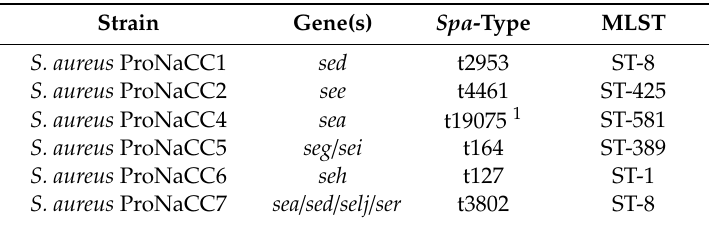
Table 3. Molecular typing of the